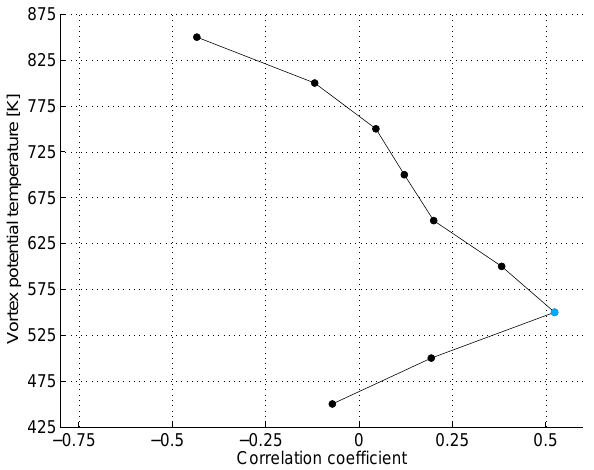
Fig. 15. Correlation of EP flux through mid latitudes in autumn and vortex mean ozone mixing ratios in early winter. The EP flux time series is the vertical component of the flux through the layer given at the vertical axis averaged over 45–75 ◦ N and from September to November. The ozone time series is the vortex mean ozone mix- ing ratio in early winter at the given layer. Correlation coefficients significant at the 95% level are shown in blue. Time series are de-